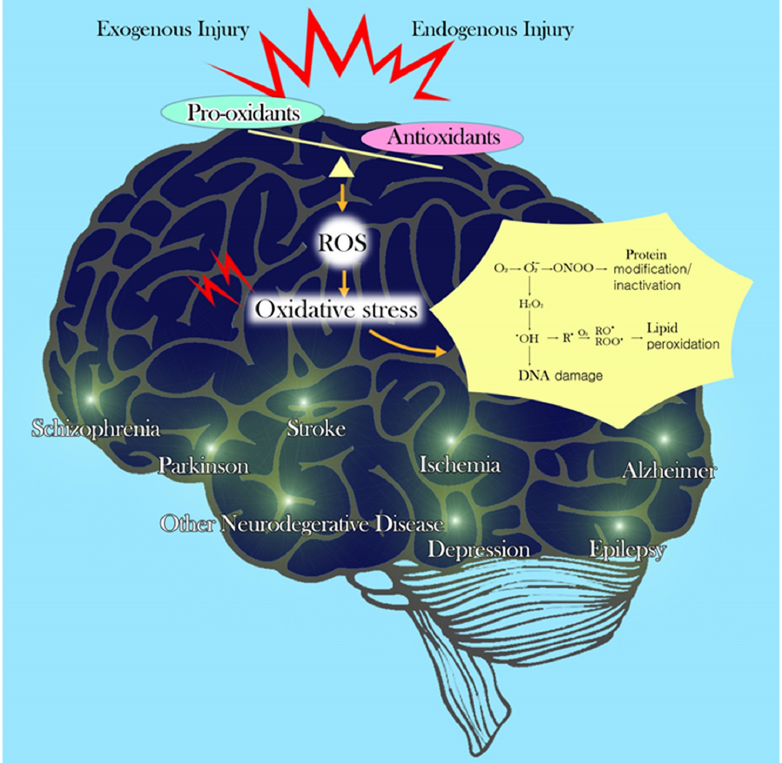
Figure 1. Development of various diseases by the pathophysiology of oxidative stress in the brain. Balance and imbalance between pro-oxidants and antioxidants against reactive oxygen species production induce oxidative stress and are consequently involved in neuronal damage resulting in the neurodegenerative